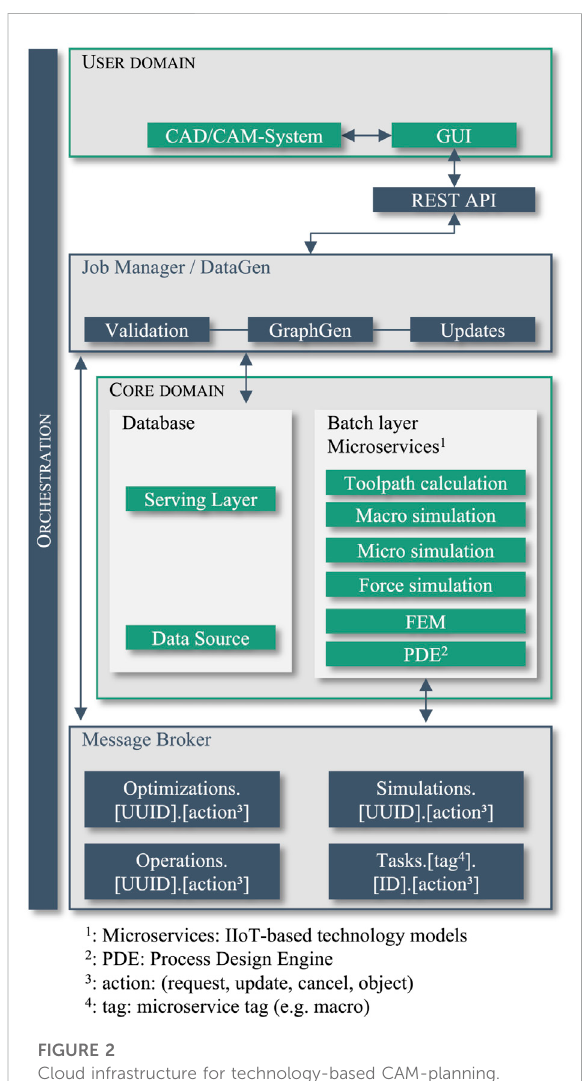
FIGURE 2 Cloud infrastructure for technology-based